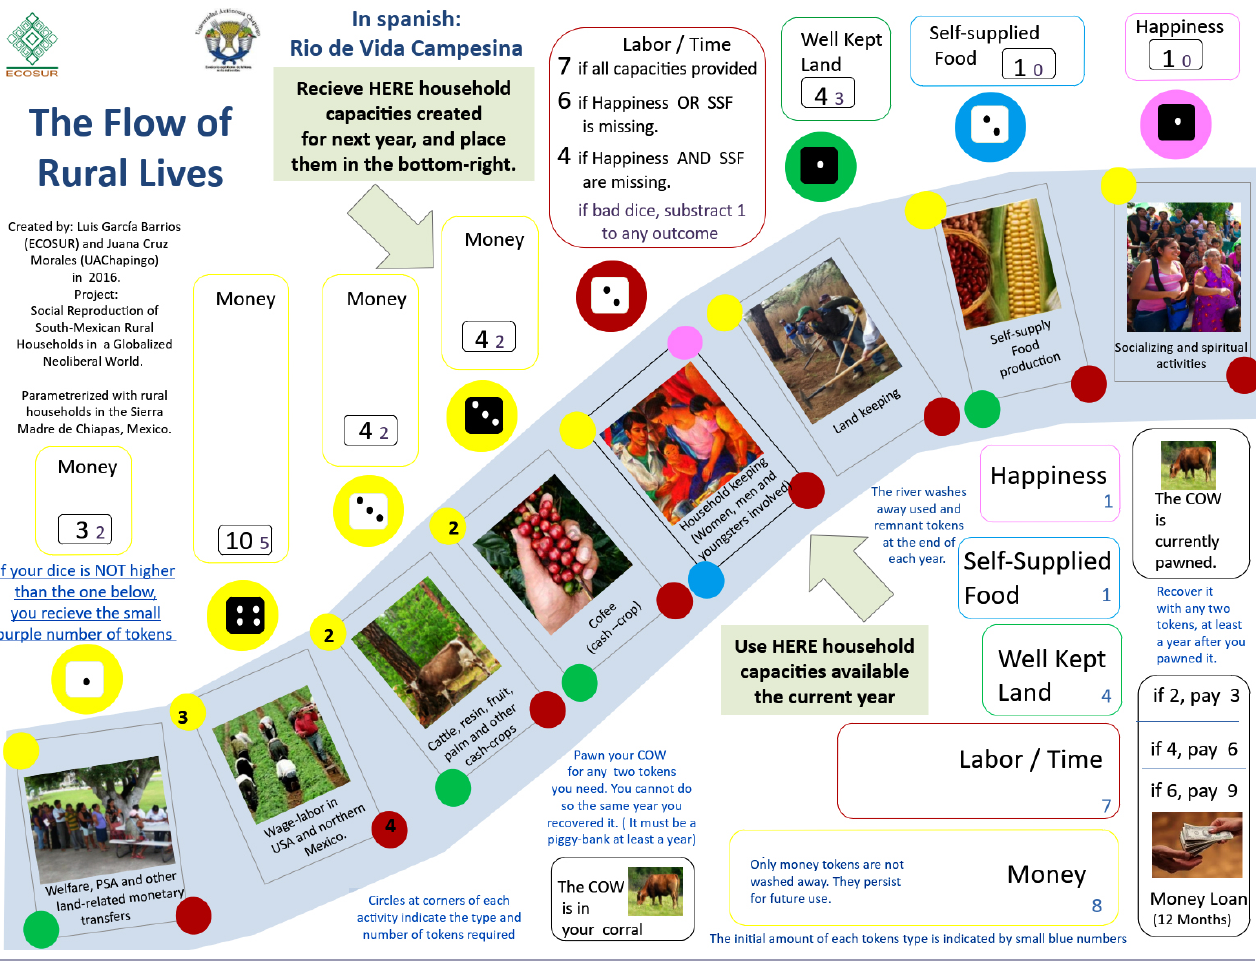
Fig. 3. Game board for The Flow of Peasant Lives. (See also the main text and game description in Fig. 2).